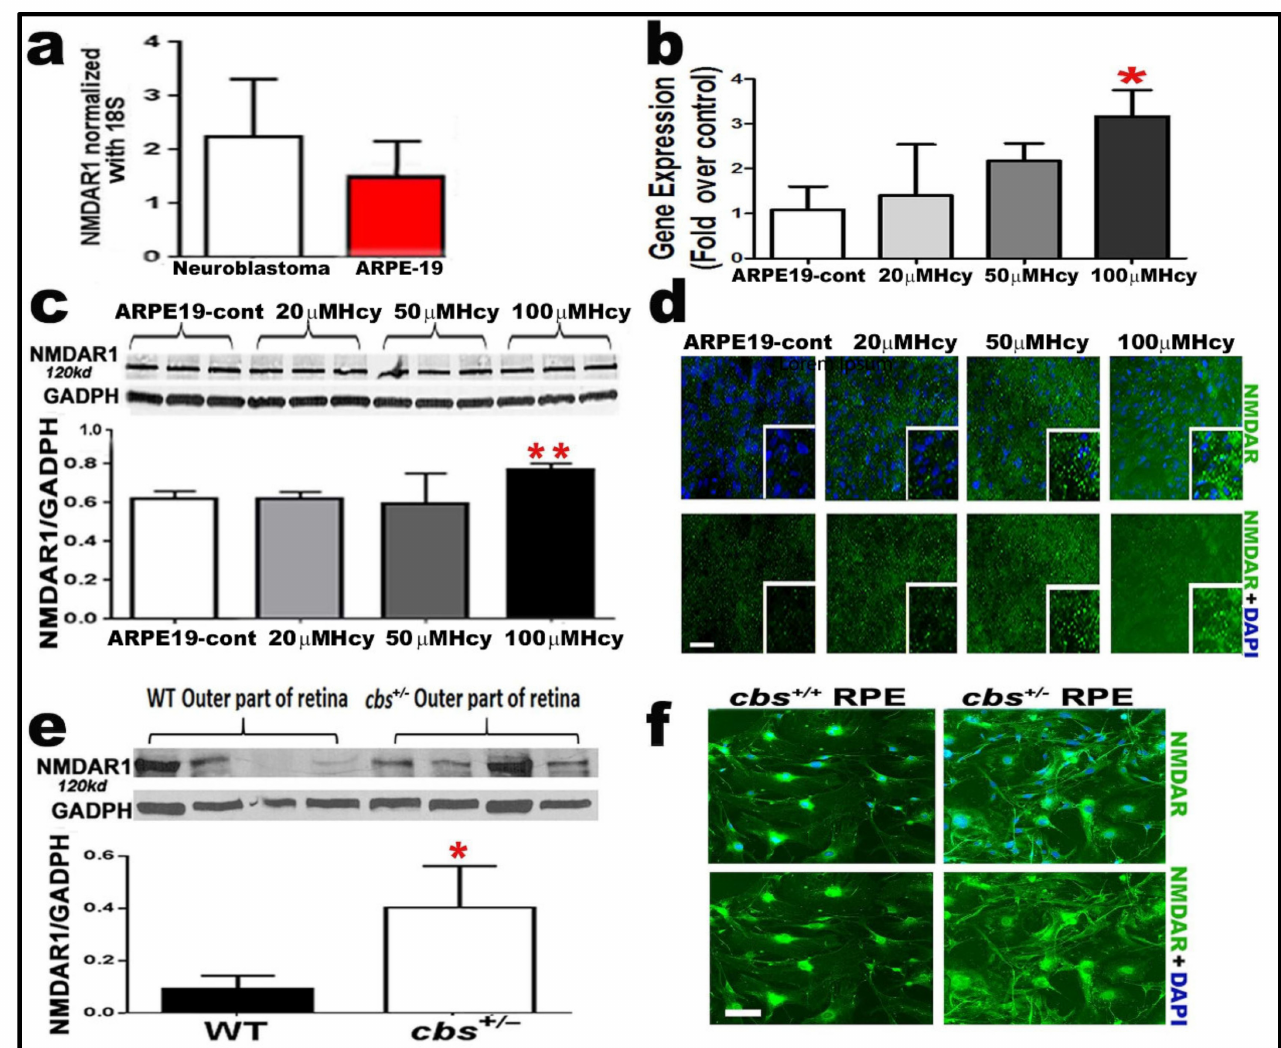
Figure 3. Evaluation of retinal epithelial cells (RPE) NMDAR expression in both in vivo and in vitro models of HHcy. ( a ) RT-qPCR analysis showing the expression of the NMDAR subunit NR1 in the human RPE (ARPE-19) cell line as compared to human neuroblastoma cells (ATCC CRL-2266) used as a positive control. ( b ) RT-qPCR analysis confirming NMDA receptor subunits NR1 (120 kD) in ARPE-19 cells and its activation by Hcy treatment (20 and 50 µ M) as compared control untreated cells. ( c ) Western blot analysis showing the expression of the NMDAR subunit NR1 in human RPE (ARPE-19) treated with different concentrations of Hcy (20, 50, and 100 µ M Hcy). GADPH was used as a loading control. ( d ) IF analysis showing the increased expression of NMDAR1 (green) in ARPE-19 treated with different concentrations of Hcy (20, 50, and 100 µ M Hcy). ( e ) Western blot analysis showing the expression of NMDAR in the outer retina (containing mainly RPE cells) of the WT mice and cbs +/ − mice. GADPH was used as a loading control. ( f ) IF analysis showing the increased expression of NMDAR1 (green) in primary RPE cells isolated from cbs +/ − mice ( n = 6 mice per group) for cells ( n = 4). Calibration bar: 50 µ m; * p < 0.05 and ** p <